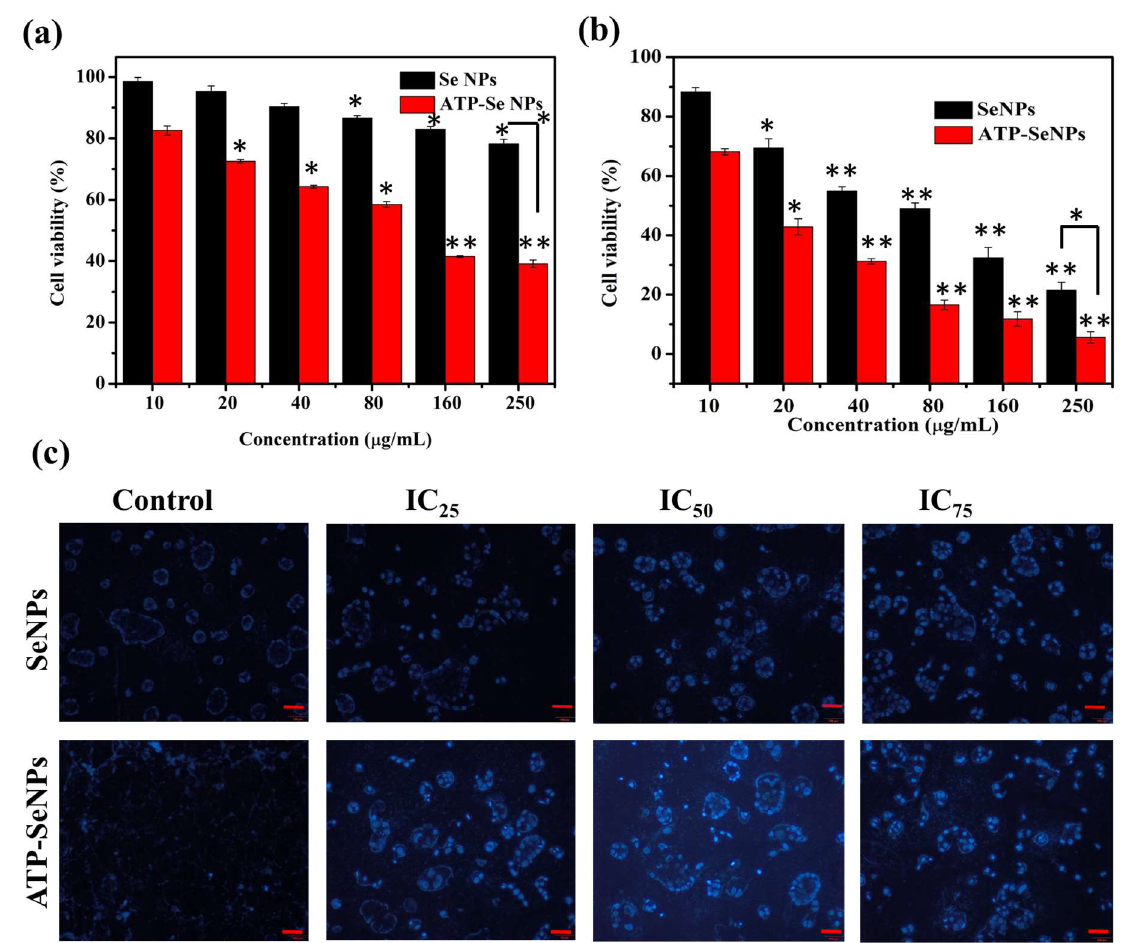
Figure 6. Cytotoxicity of SeNPs and ATP-SeNPs in HEK293 cell line and ( a ) human colon cancer (caco-2) cell lines, ( b ) and analysis of SeNPs and ATP-SeNPs-induced nucleus damage in caco-2 cells by DAPI staining assay (c). Scale bar (100 µm). * p < 0.05; ** p < 0.01 significantly varied between the low concentration (10 µg/mL) and between type of the nanoparticles.